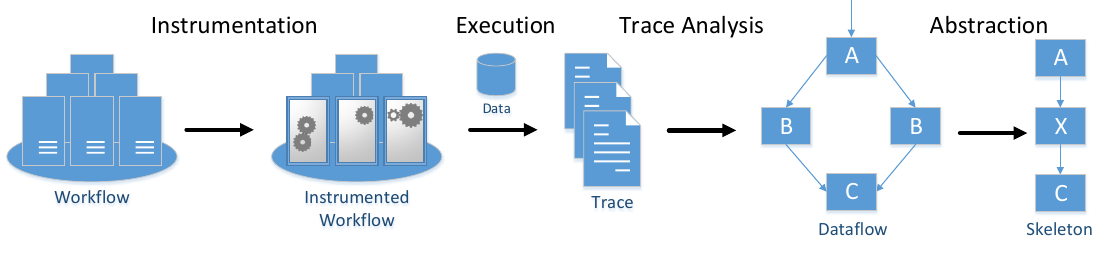
Figure 2: Workflow Instrumentation for Structure Extraction (WISE)